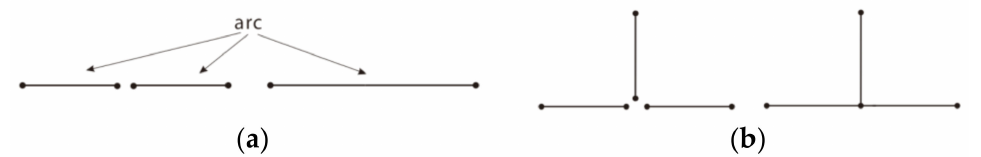
Figure 5. Connecting line segments. ( a ) Two separated nodes and their connection result and ( b ) three separated nodes and their connection